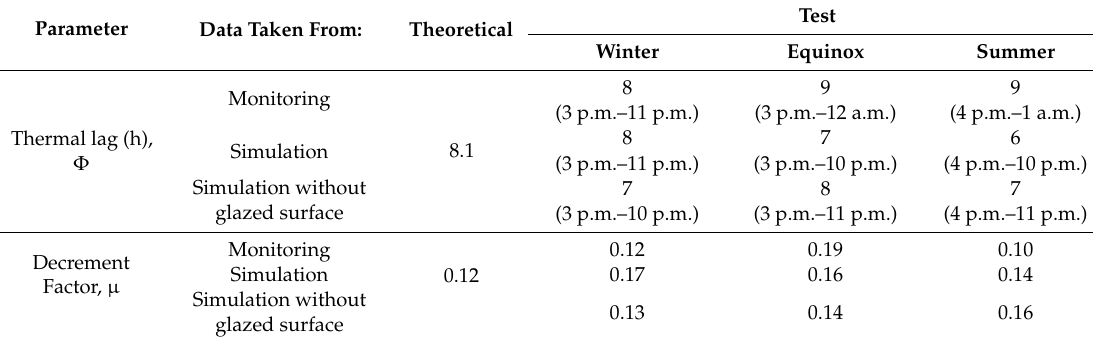
Table 4. Thermal lag and decrement factor of the Earthbag building in theoretical, simulated and monitoring cases for winter solstice, equinox and summer